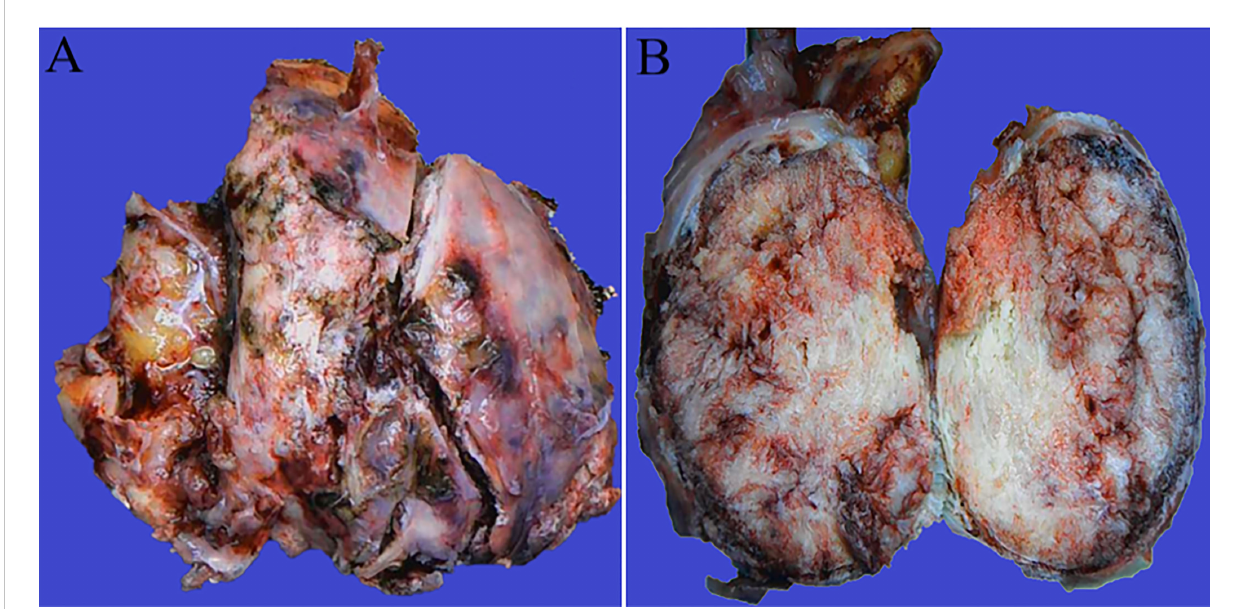
FIGURE 2 Gross pathological examination. Thoracic cavity: a grayish-white solid mass with indistinct borders (A) . The mass was 9.5 cm × 8.4 cm × 5.3 cm in size. Bleeding and calci fi cation were visible in the transverse section (B)